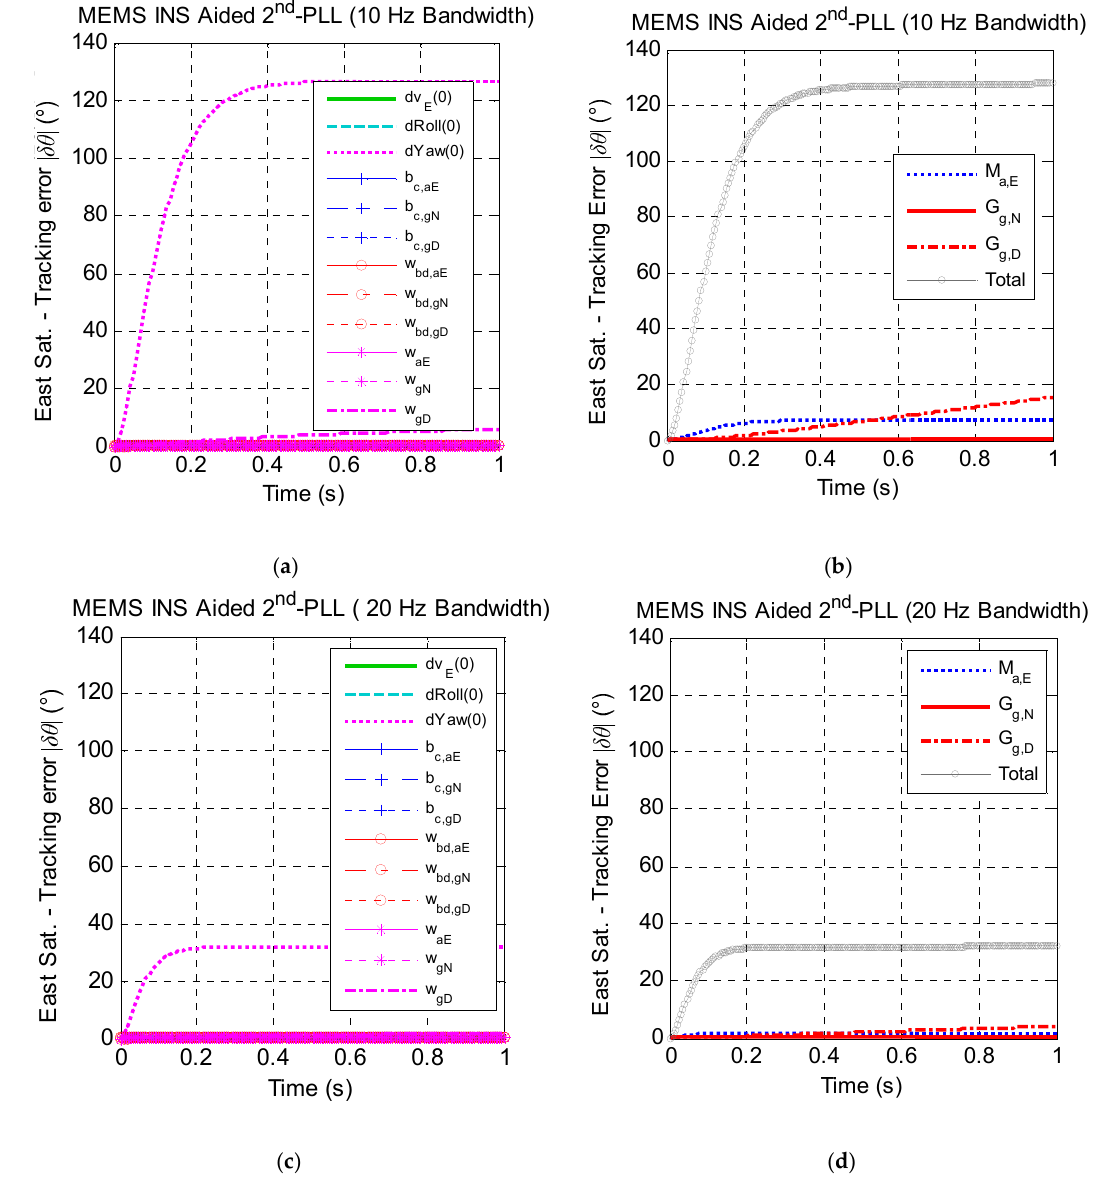
Figure 7. The east satellite tracking error caused by MEMS INS error sources under the assumption of linear high dynamics along the north direction. ( a ) Effect of non-maneuver-dependent error with a 10-Hz bandwidth; ( b ) effect of maneuver-dependent error with a 10-Hz bandwidth; ( c ) effect of non-maneuver-dependent error with a 20-Hz bandwidth; ( d ) effect of maneuver-dependent error with a 20-Hz bandwidth. (* Here, Sat. is the abbreviation of satellite.)